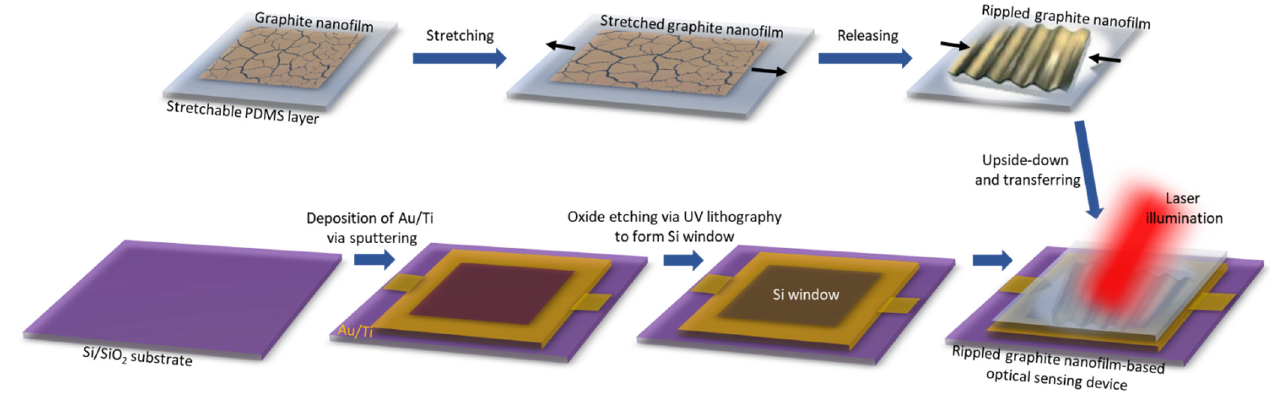
Figure 1. Fabrication process of rippled graphite nanofilm-based optical sensing device. To analyze the multilayer phase and the disorder of the graphite nanofilms